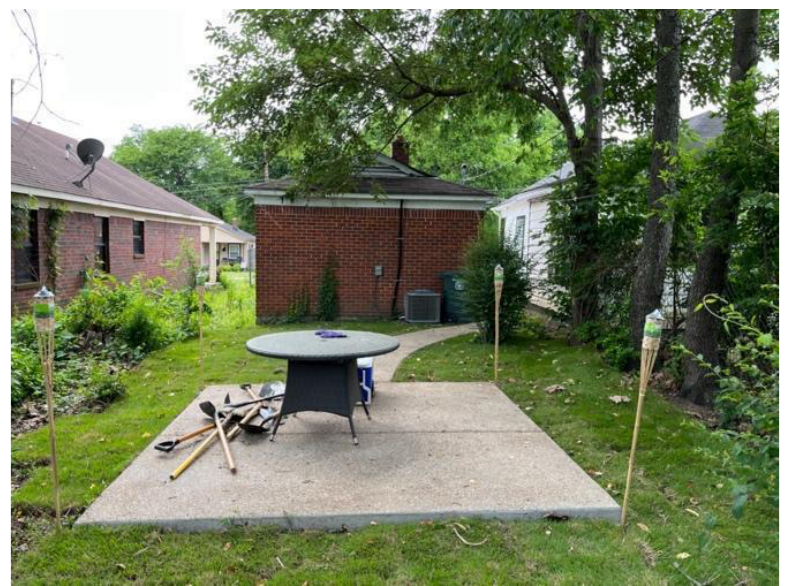
Figure 5. The backyard of one of the tiny homes completed in 2022 has direct access from the sidewalk. It was constructed in part by volunteers and is intended to be used as a community space.